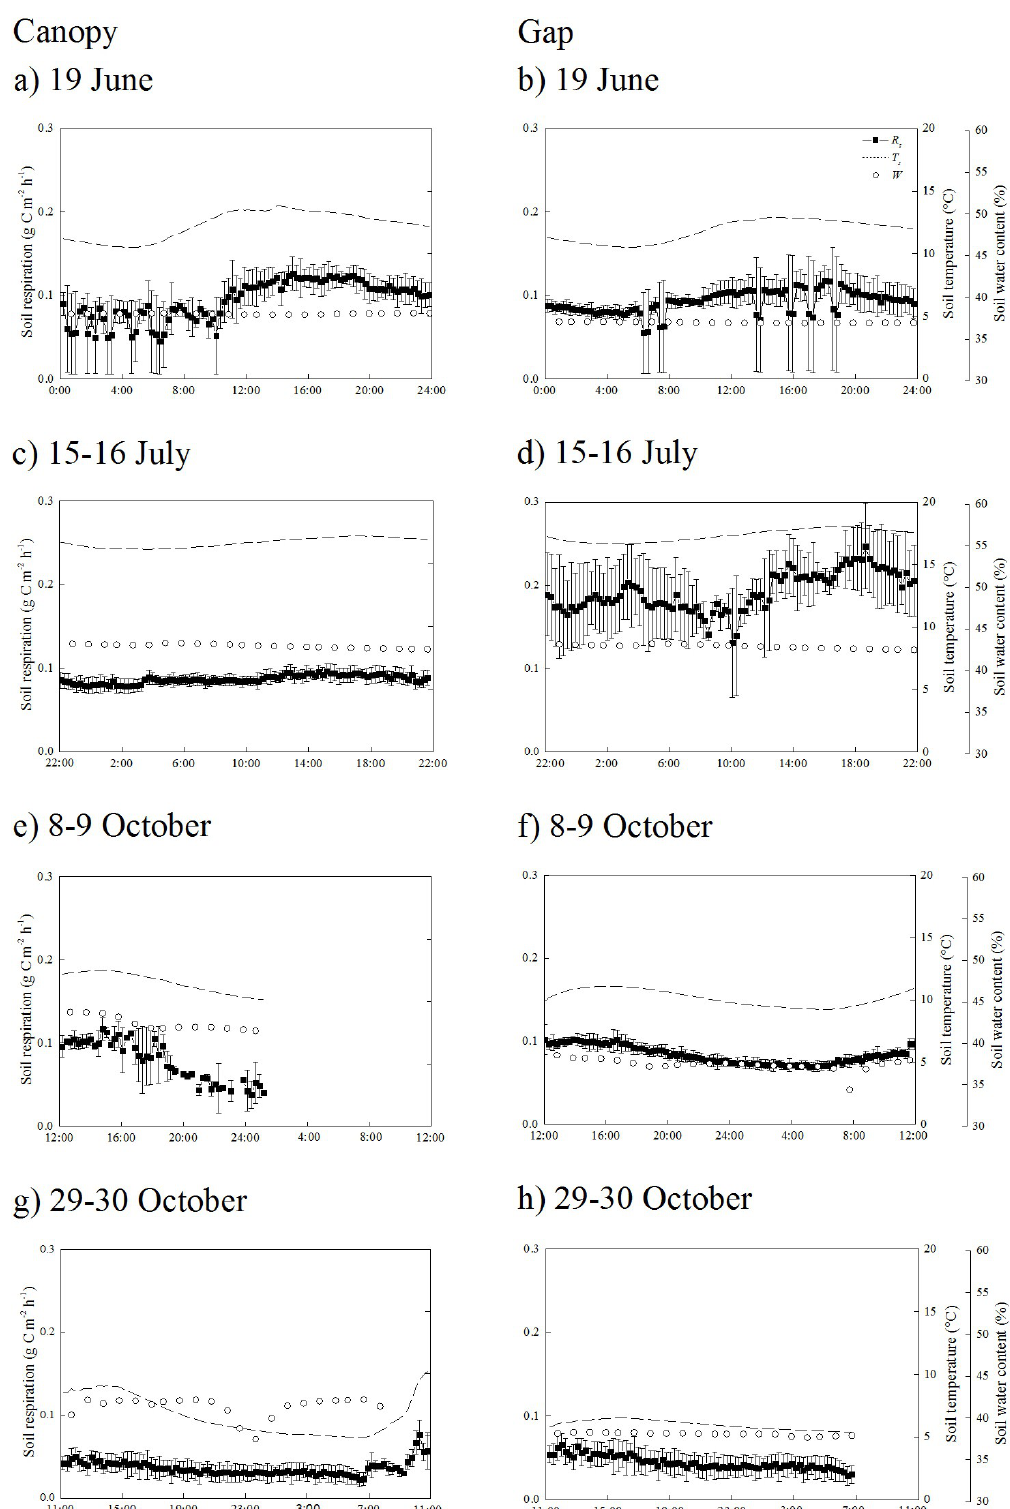
Figure 6. Diurnal patterns of soil respiration ( R s ) measured using the AOCC system, soil temperature ( T s ), and soil water content ( W ) for canopy and gap areas during 19 June ( a , b ), 15–16 July ( c , d ), 8–9 October ( e , f ) and 29–30 October ( g , h ) 2014. Diurnal R s at C1 in September and early October could not be measured because of problems with automatic chamber closure. Error bar represents the standard error of the mean.